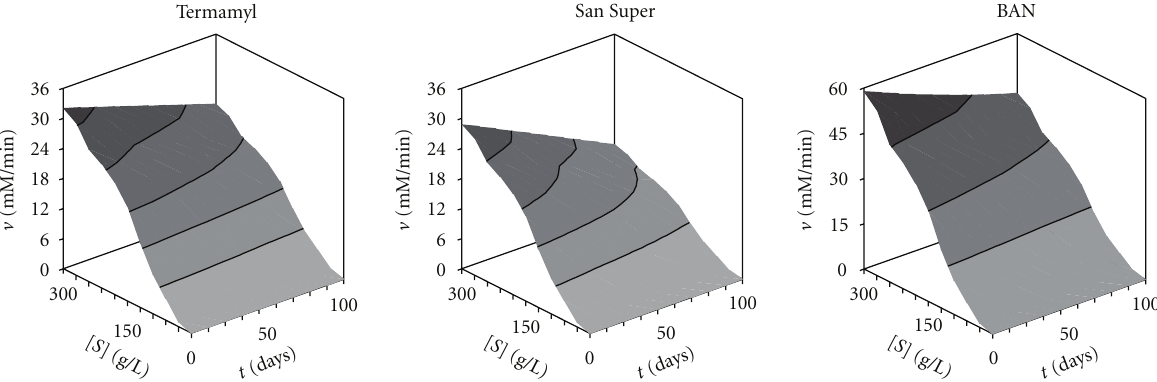
Figure 4: Response surfaces plot showing the e ff ect of the ageing time ( t ) and the starch concentration [ S ] on the amylolytic activity ( v ) of the three enzymes.